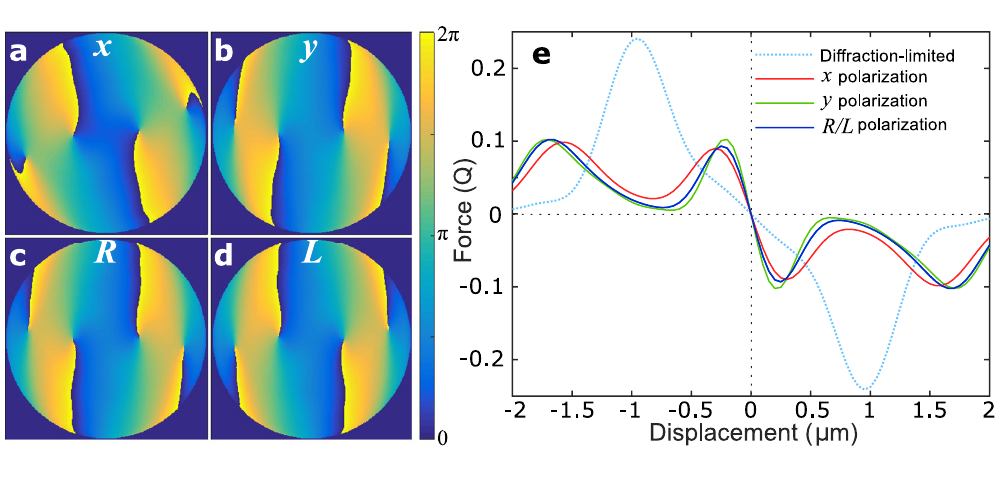
Figure 4. SPOT performance with different polarizations. ( a – d ) Example phase profiles optimized for 2 μ m spheres are shown for x , y , right circular ( R ) and left circular ( L ) respectively, with the trap optimized along the x axis. The different polarization states are optimized with slightly different profiles. Similar to the Eigenmode method, left and right circular polarizations are optimized with mirror-image profiles. The optima calculated for the different polarizations are dissimilar for all particle sizes, though the difference is more pronounced for smaller particles where the phase features are generally larger. ( e ) The resulting forces differ, with y polarized light achieving the strongest trap and x polarization the weakest, and identical forces calculated for right and left circular